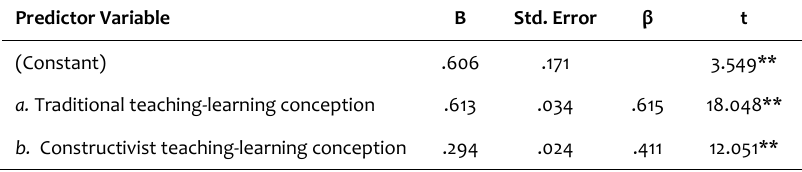
Table 4: Prediction Level of Teachers’ Teaching-Learning